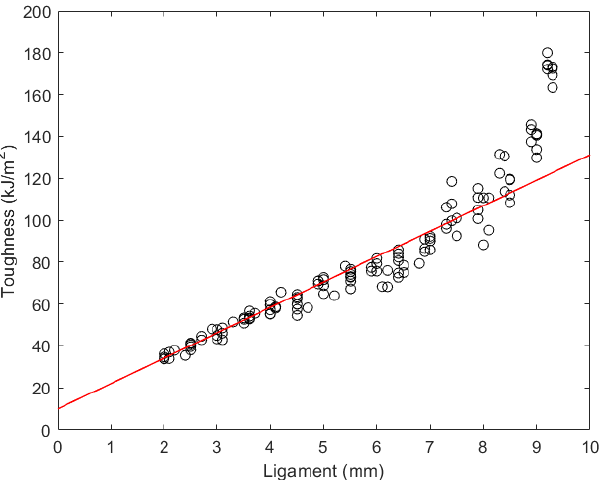
Figure 3. Special fracture toughness versus the ligament. Circles: experimental data on PLA samples. Solid line: Results of numerical simulation with w 0 = 9.90 kJ/m 2